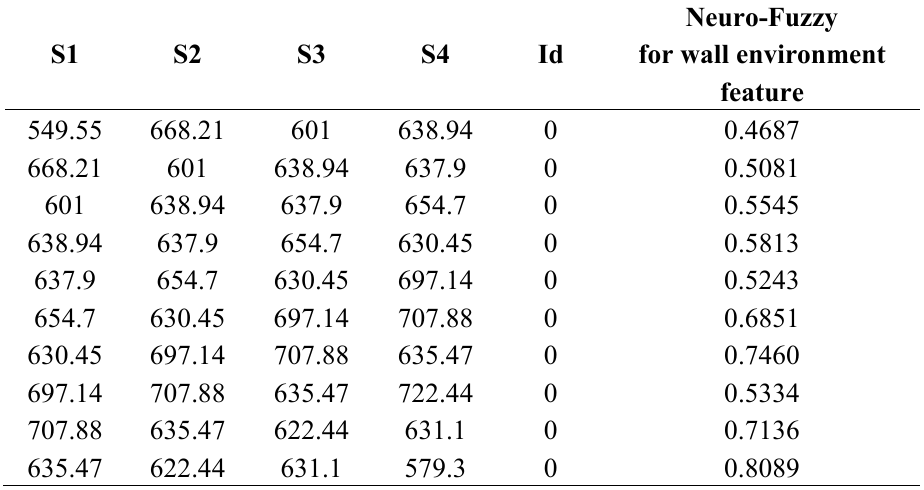
Table 8. Outputs of the Neuro-Fuzzy systems for real data when the vehicle is going towards a frontal wall as it is seen in Figure